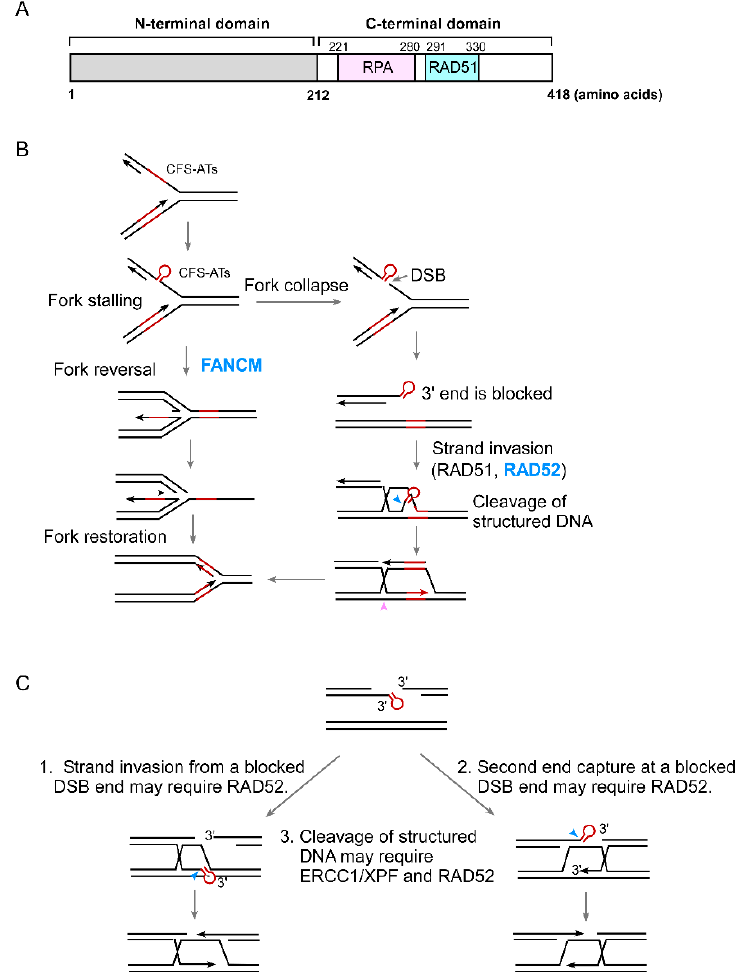
Figure 2. Proposed models for the role of RAD52 in repair of DSBs containing DNA secondary structures. ( A ) The domain structure of human RAD52. RPA and RAD51: domains of RAD52 that interact with RPA and RAD51, respectively. ( B ) The model of the roles of FANCM in removing DNA secondary structures on the forks and RAD52 in repairing DSBs with secondary structures at the ends. ( C ) Proposed mechanisms for how RAD52 is involved in repair of DSBs carrying DNA secondary structures.